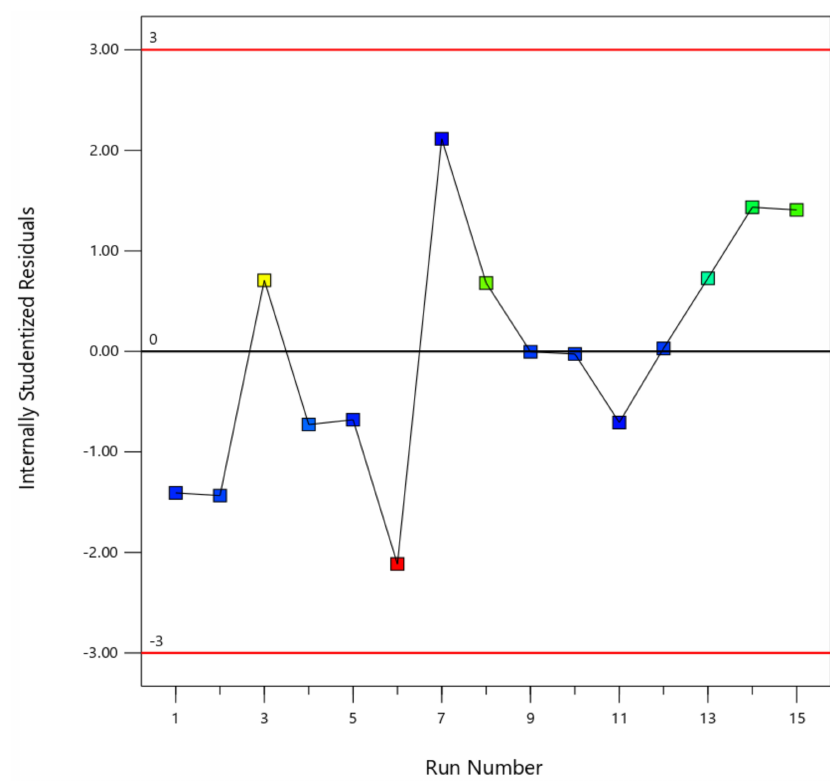
Figure 7. Plot of studentized residuals vs. run